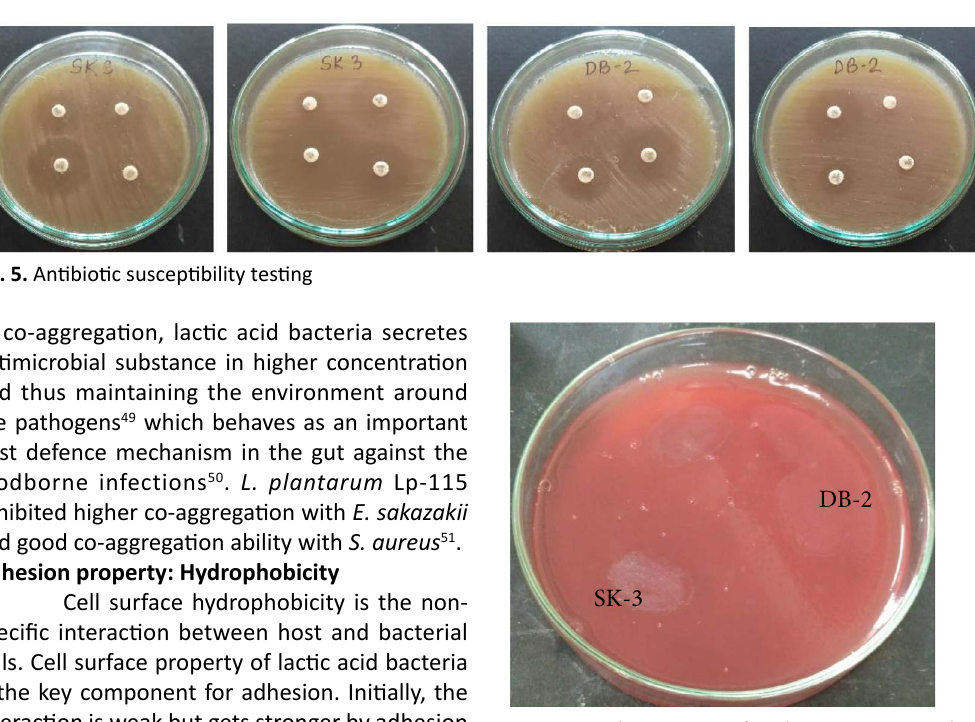
Fig. 6. Hemolytic activity of L. plantarum DB-2 and SK-3